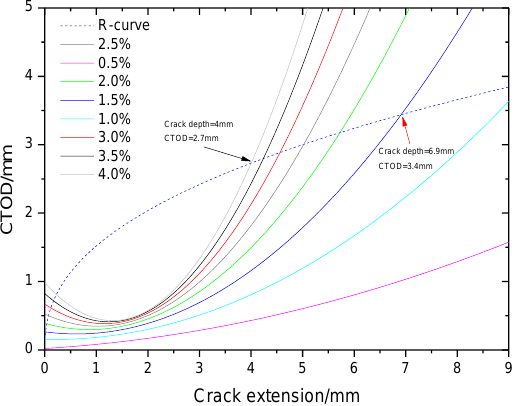
Figure 11. Comparison between crack growth resistance curve and crack growth driving force curves.